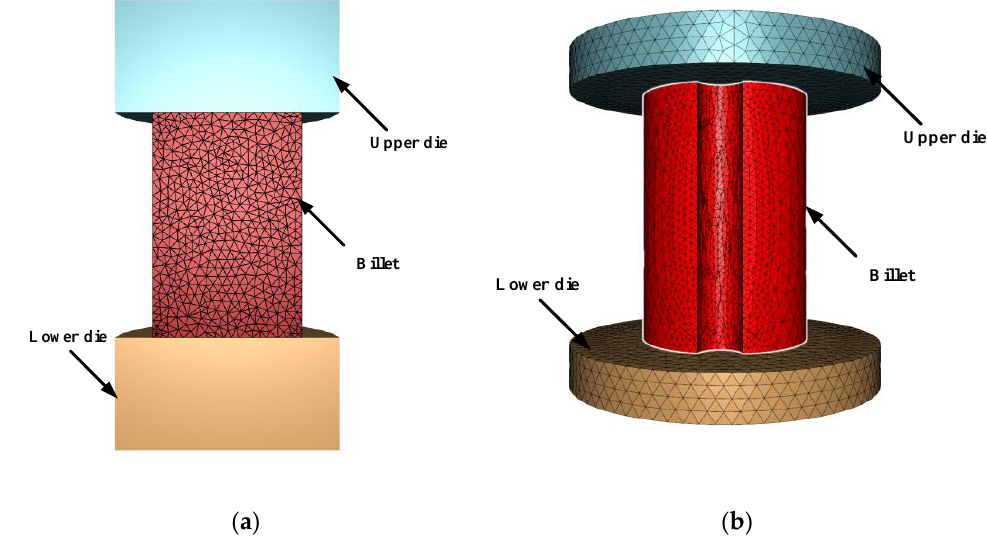
Figure 14. Models of different shapes: ( a ) Ø 8 × 12 mm half sample model; ( b ) the cylindrical sample (Ø 8 × 12 mm) with a notch radius of 1 mm.